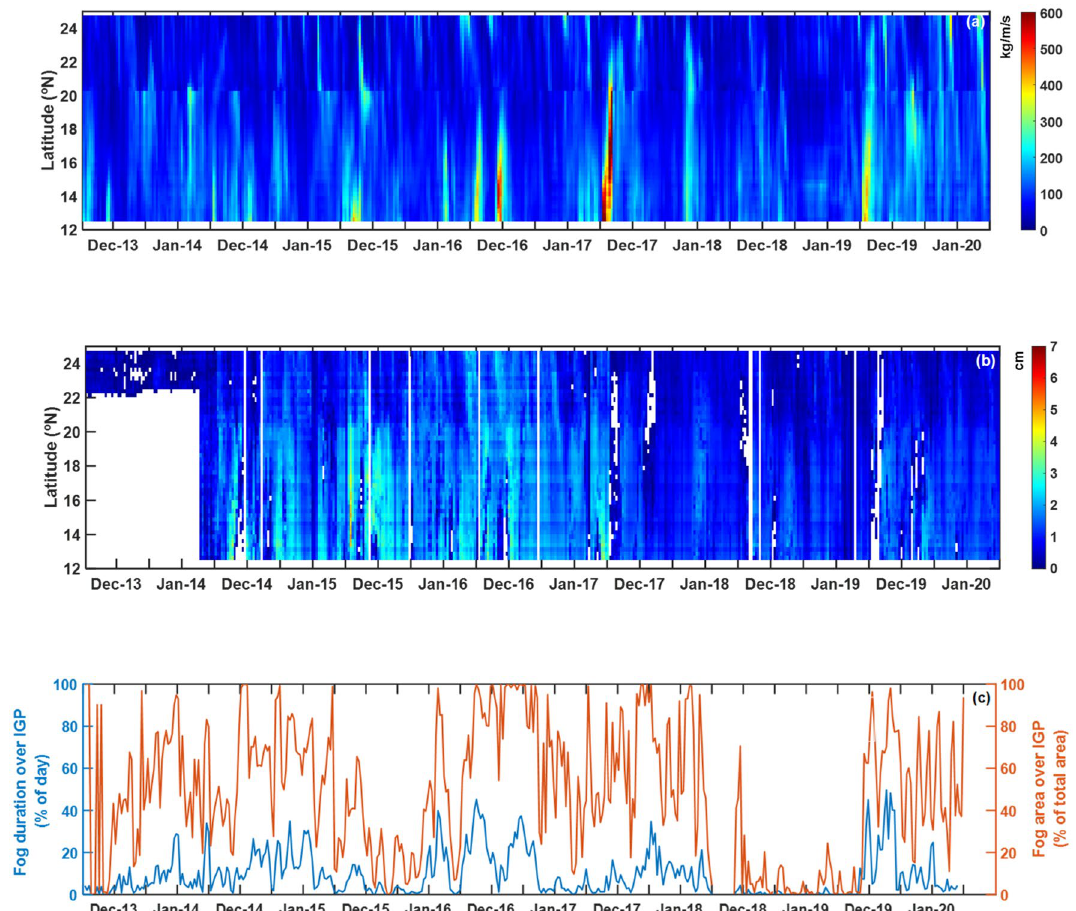
Figure 5. Concomitant of AR-landfall to the intensification of fog over IGP. Temporal variation of ( a ) IVT (in Kg/m/s) and ( b ) PWV (cm) along the west coast of India for December and January months during 2013–2020. ( c ) Temporal variation of fog duration (in blue colour) and spatial extent of fog (in orange color) over IGP region. White color in figure ( b ) indicates non-availability of